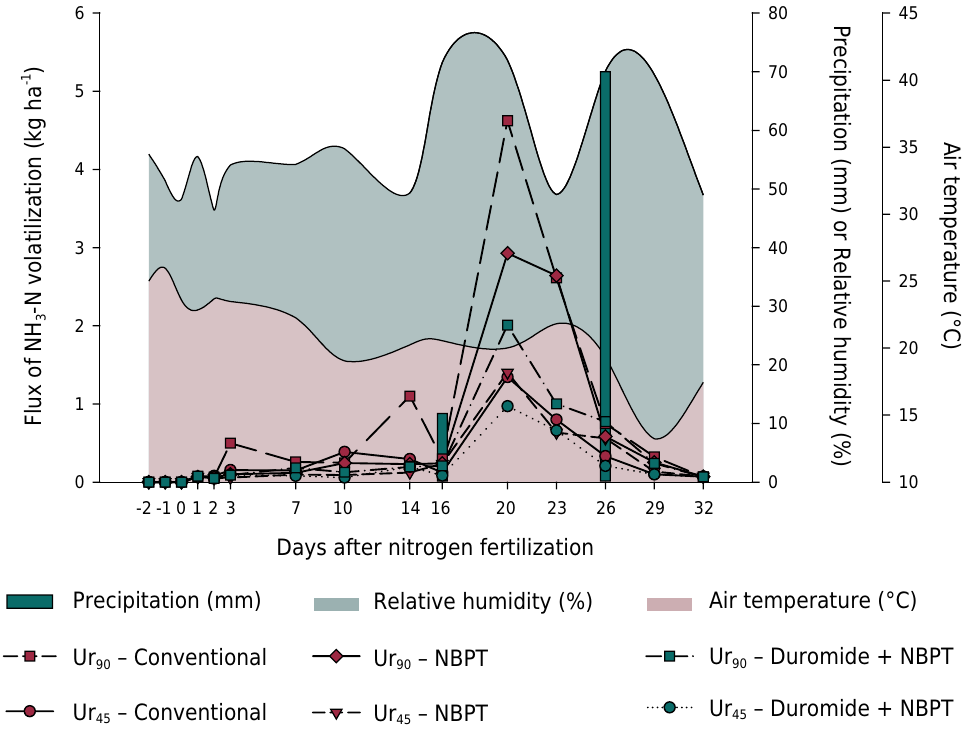
Figure 1. Air Relative humidity, pluviometric precipitation, air temperature (°C), and NH 3 -N (kg ha -1 ) volatilization flux overtime after corn nitrogen fertilization with different nitrogen doses (45 and 90 kg ha -1 ) and sources (Urea, Ur-NBPT, and Ur-Duromide + NBPT) in a Latossolo Vermelho Distroférrico